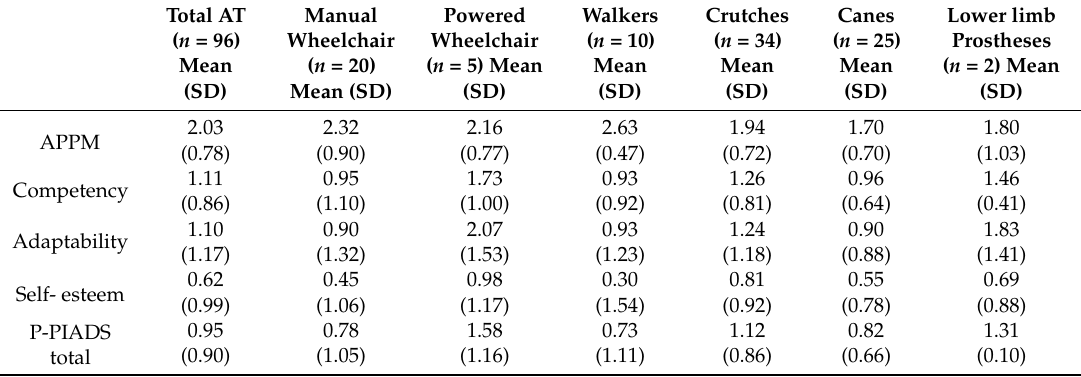
Table 1. Participation profile and psychosocial impact of AT by group of assistive device.